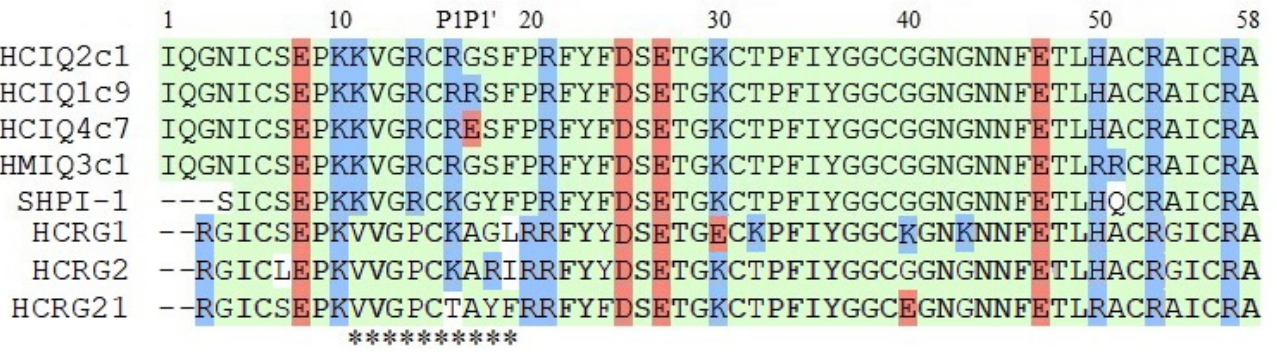
Figure 2. Isolation and molecular mass of HCIQ1c9: ( a ) HPLC elution profile of HCIQ1c9 on a Jupi- ter C4 reverse-phase column (10 × 250 mm), using a linear gradient of acetonitrile concentrations (0–